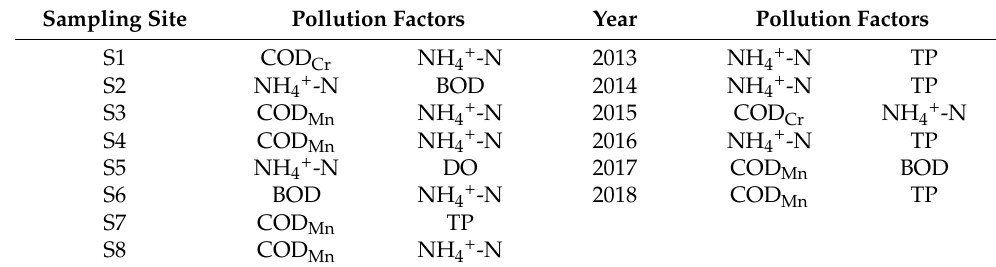
Table 7. Key pollution indicators of each sampling site and each